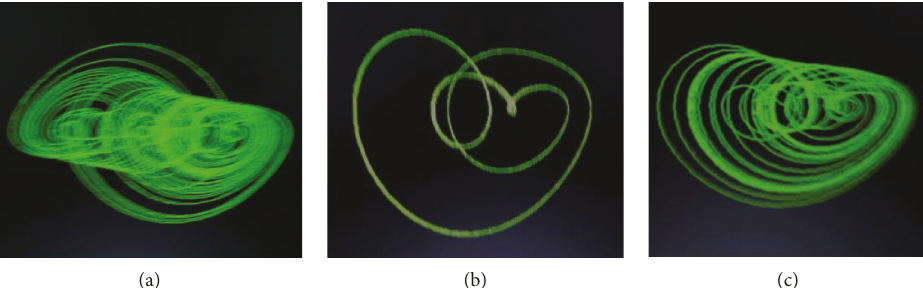
Figure 13: Experimental observation of (a) 2-scroll chaotic behavior; coexistence of (b) period-3 behavior and (c) 1-scroll chaotic behavior on the x - y